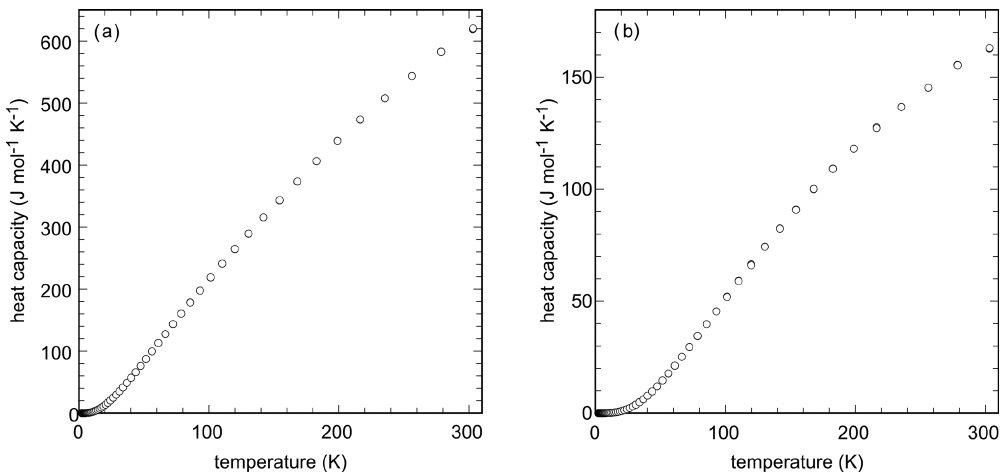
Figure 2. Low-temperature heat capacity of (a) brandholzite and (b) byströmite. Table 5. Summary of the enthalpies of formation for the reference phases and the enthalpies of formation calculated from the calorimetric data in lead borate or sodium molybdate in this work. “No.” is the reaction number of the reactions in Table 3. All data are in kJmol − 1 . Enthalpies of formation for reference phases from Robie and Hemingway (1995), with the exception of the datum for Sb 2 O 5 (data from this work and Abramchuk et al.,